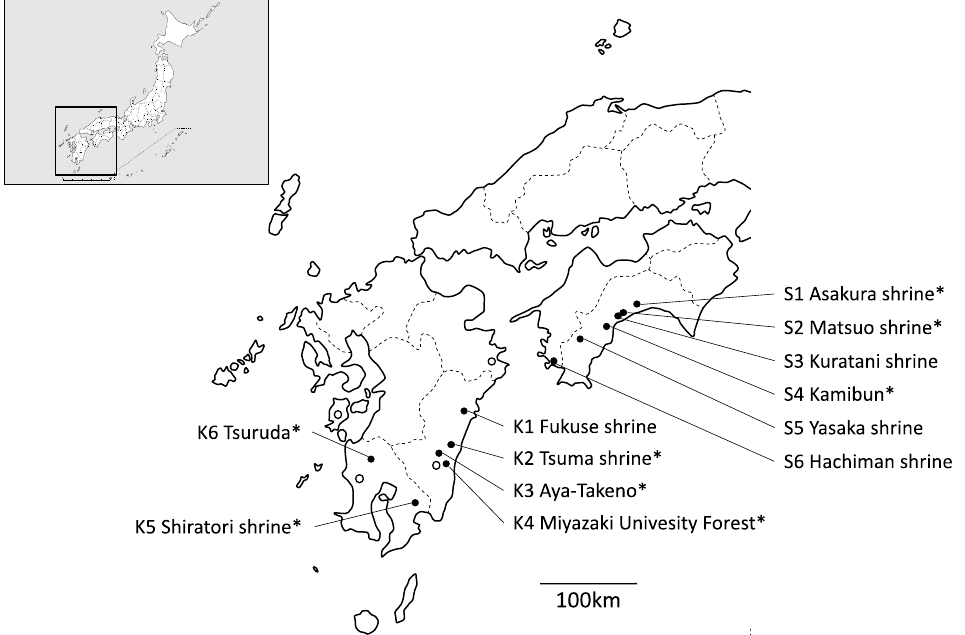
Figure 1. Populations of Q. hondae sampled in this study (solid circles). Open circles indicate areas where Q. hondae exists but was not sampled in this study. Q. glauca individuals were also collected from populations with asterisks.